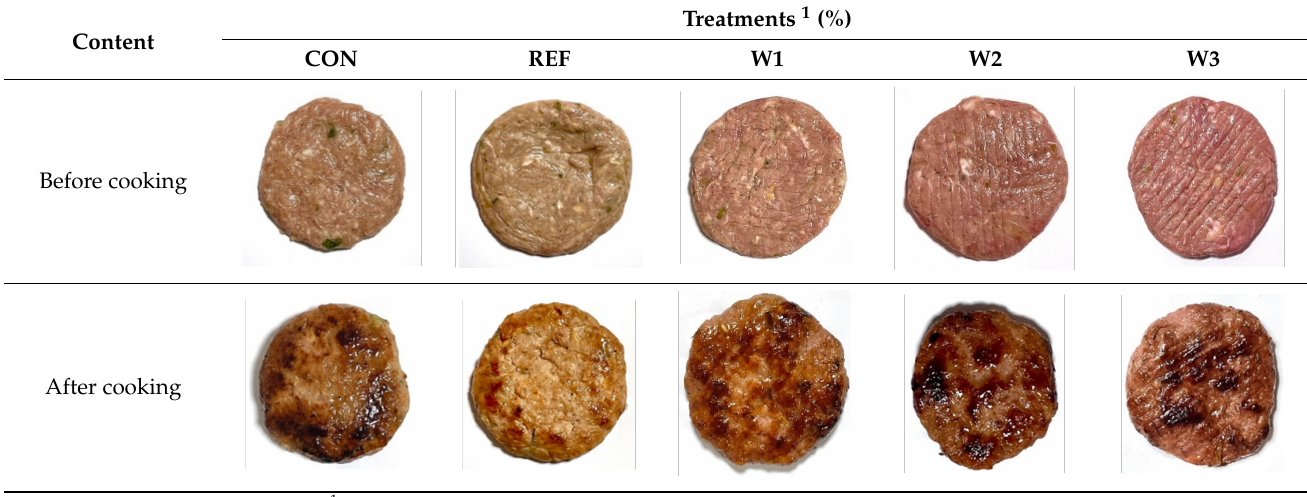
Table 6. Appearance of Tteokgalbi treated with watermelon radish powder before and after cooking.